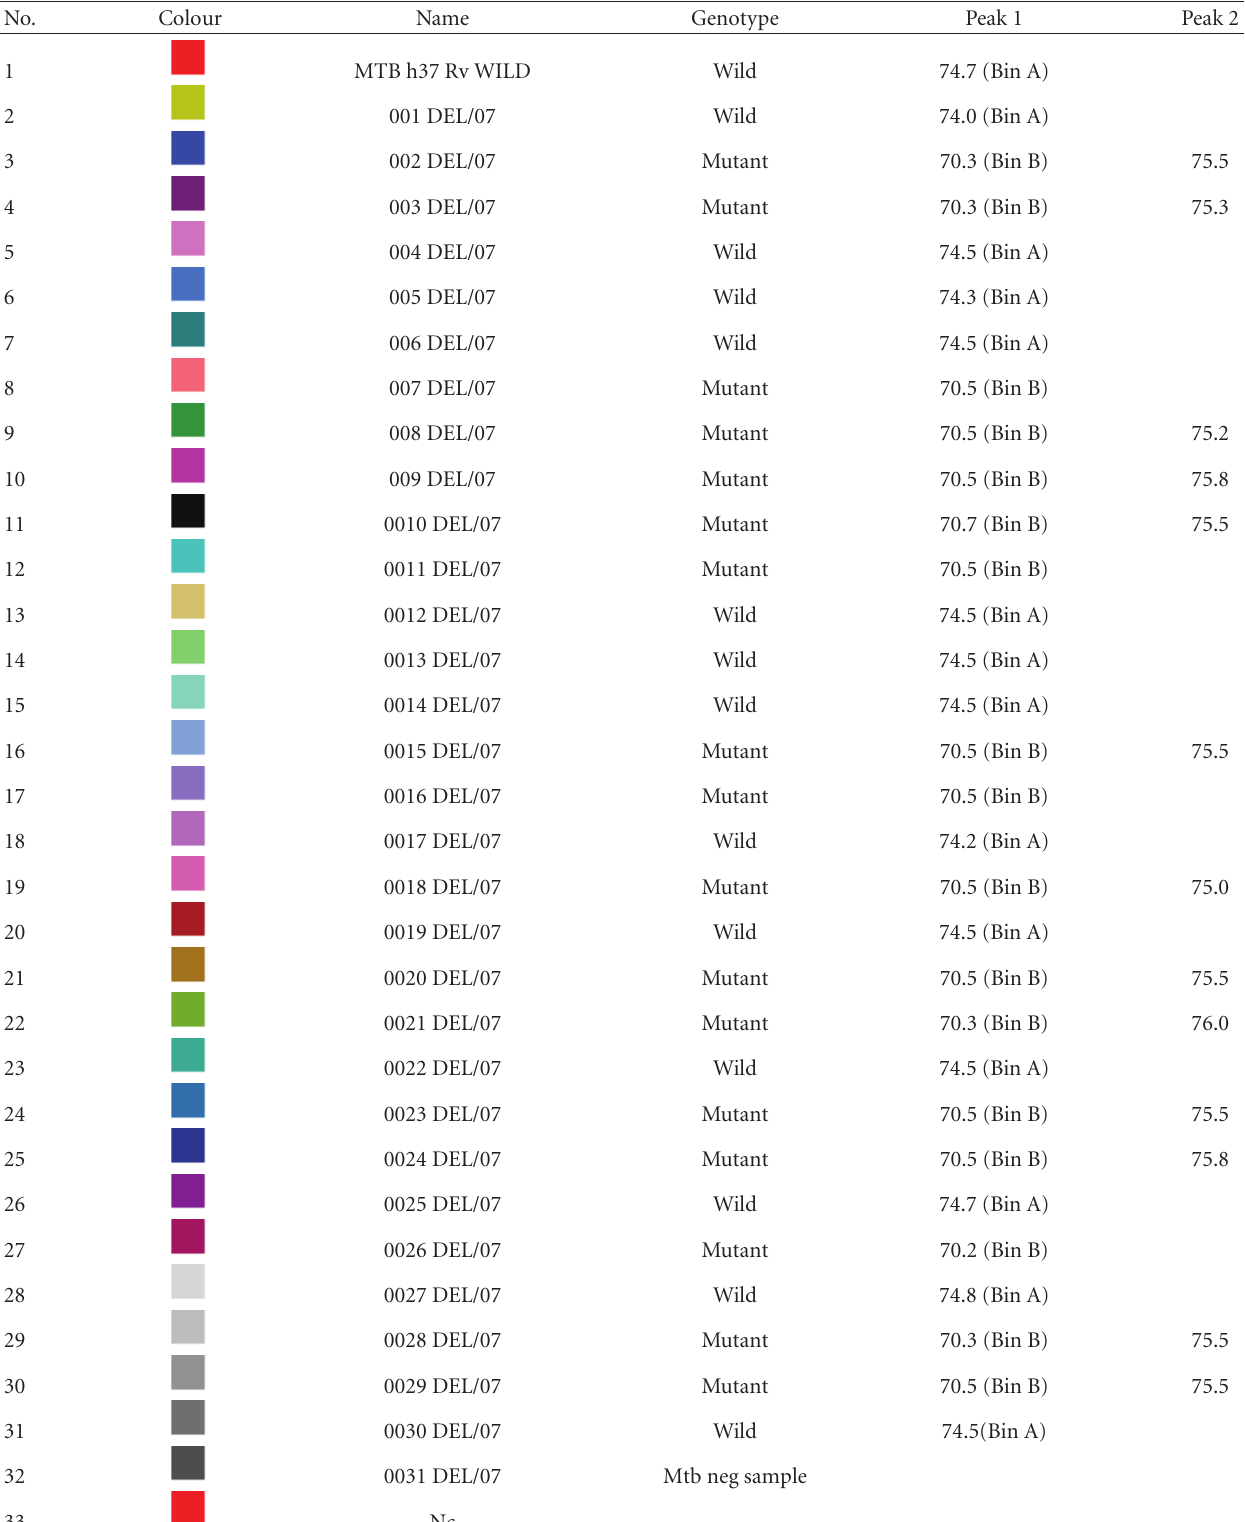
Table 1: Real-time PCR results showing drop in T m . (wild/mutant rpob gene with di ff erent T m , Bin A: Wild, Bin B: Mutant).